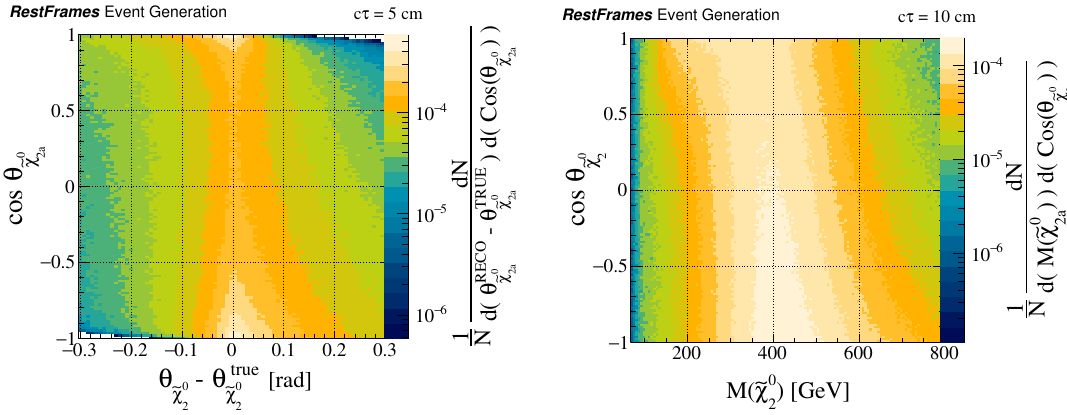
Figure 11 . (Left) Cosine of the LLP decay angle as a function of reconstructed decay angle error. (Right) Cosine of the LLP decay angle as a function of reconstructed LLP mass. An LLP mass of 400 GeV is assumed when simulating these